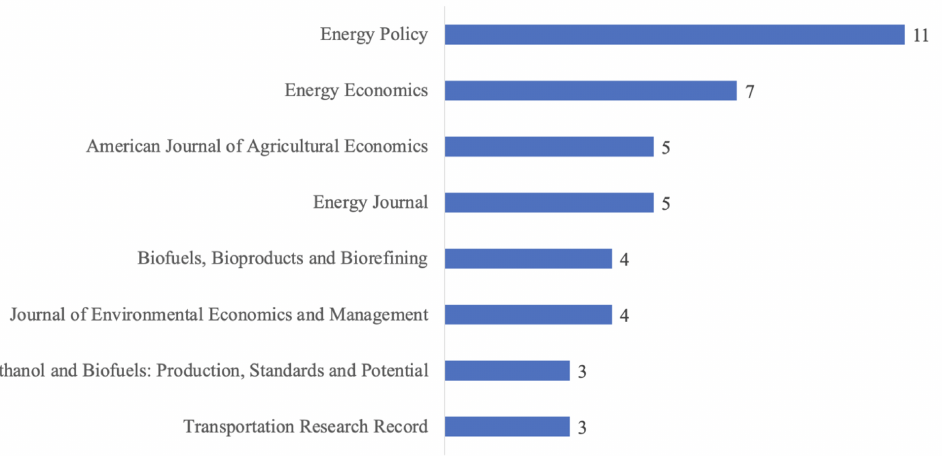
Figure 4. Most frequent journals in the